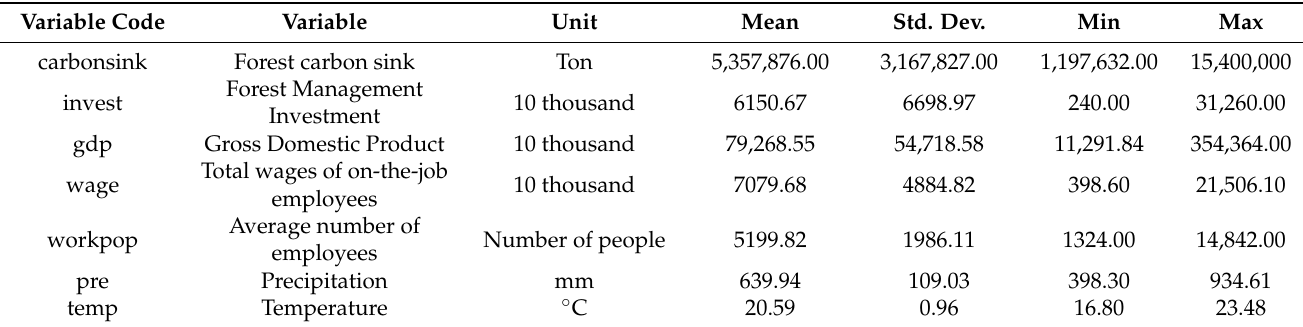
Table 1. Variable design and descriptive